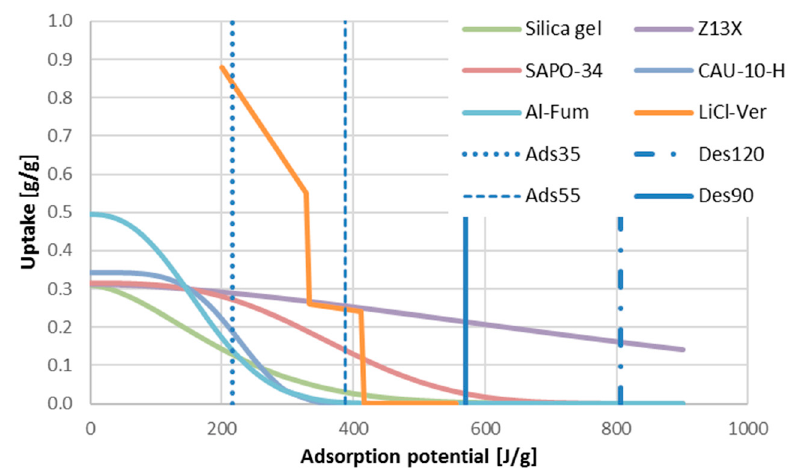
Figure 3. Plot of the adapted Dubinin-Astakhov-Regressions and the LiCl-Ver equilibrium line used to determine the water uptake (and finally storage capacity) of the considered thermo-chemical materials (TCMs). The vertical lines indicate the applicable limits of adsorption potential for the studied scenarios (35 °C and 55 °C adsorption and 90 °C and 120 °C desorption temperature, respectively; condensation and evaporation temperature are fixed at 20 °C and 10 °C, respectively).